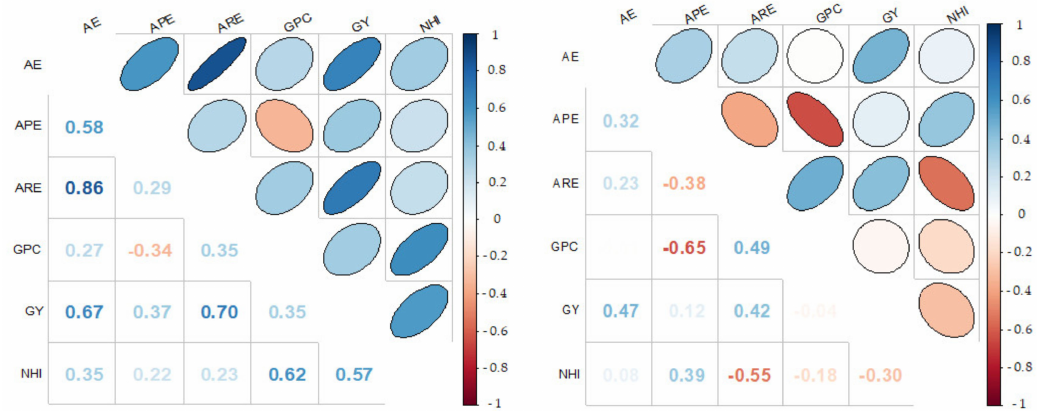
Figure 3. Correlation matrix of the nitrogen use efficiency components: agronomic efficiency (AE), agro-physiological efficiency (APE), apparent recovery efficiency (ARE), nitrogen harvest index (NHI), grain protein content (GPC), and grain yield (GY), for the two years, ( left : wet year, right : dry year). All the correlation results were subjected to a path coefficient analysis to detect each variable’s direct or indirect effect on grain yield in the two growing seasons, depending on the nitrogen fertilizer application. In the first step (Table 5), a path coefficient analysis was conducted on GY and its components. The variables are the number of grains · m − 2 , TGW, N.S, and GPC, and in the second step (Table 6), the variables are the NUE and its components: NHI, ARE, GPC, APE, and